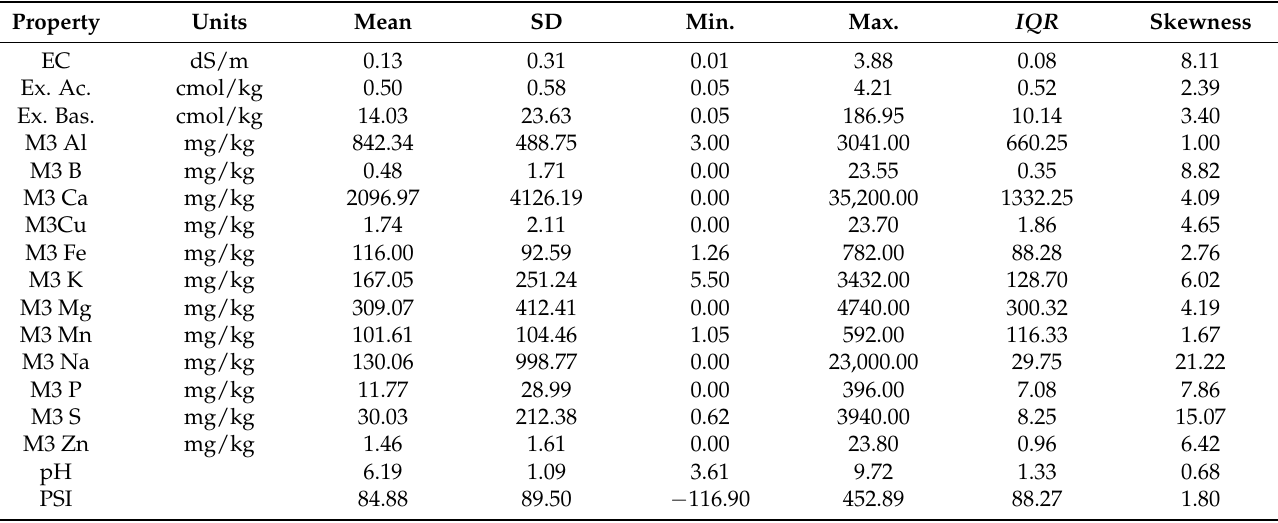
Table A5. Descriptive statistics of properties in the “Mehlich”